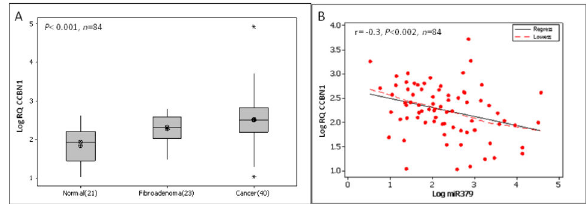
Figure 3. Cyclin B1 expression in normal, fibroadenoma and malignant breast tissues. (A) Cyclin B1 gene expression across all tissue types. Cyclin B1 gene expression was significantly elevated in breast cancer (Mean(SEM) 2.52 (0.10) Log RQ) compared to benign (2.15 (0.11) Log 10 and normal breast tissue (1.78 (0.10) p<0.001). (B) Pearson Correlation of miR-379 and Cyclin B1. A significant negative correlation was observed between Cyclin B1 and miR-379 (r=-0.31, p<0.001).